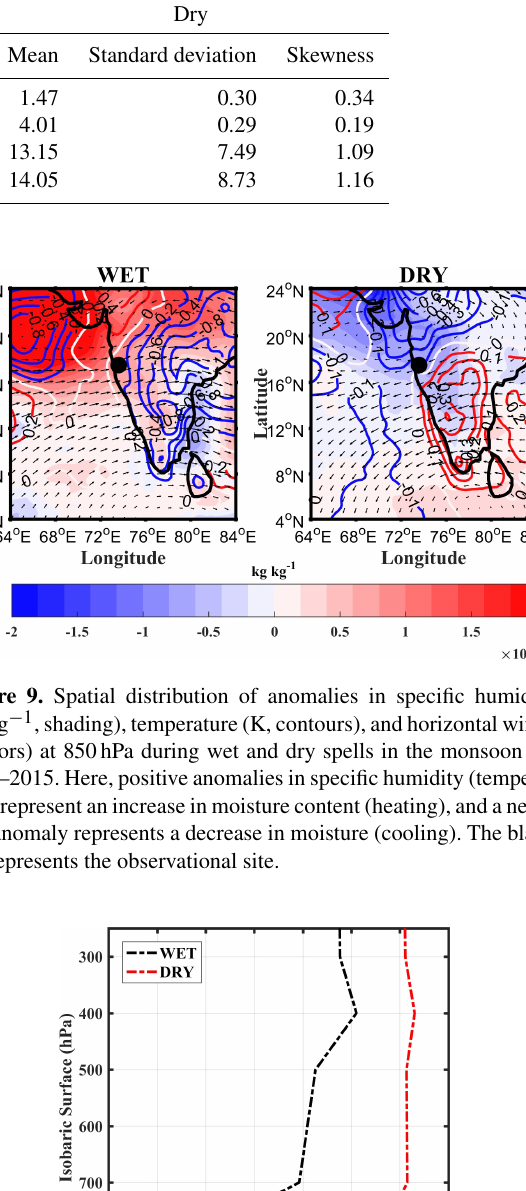
wet and dry spells. Here, negative values of omega repre- sent updrafts and vice versa. The mean vertical winds are negative in wet spells, indicating updrafts, whereas the mean vertical winds are small and positive, indicating downdrafts during dry spells. The updrafts do not allow the smaller